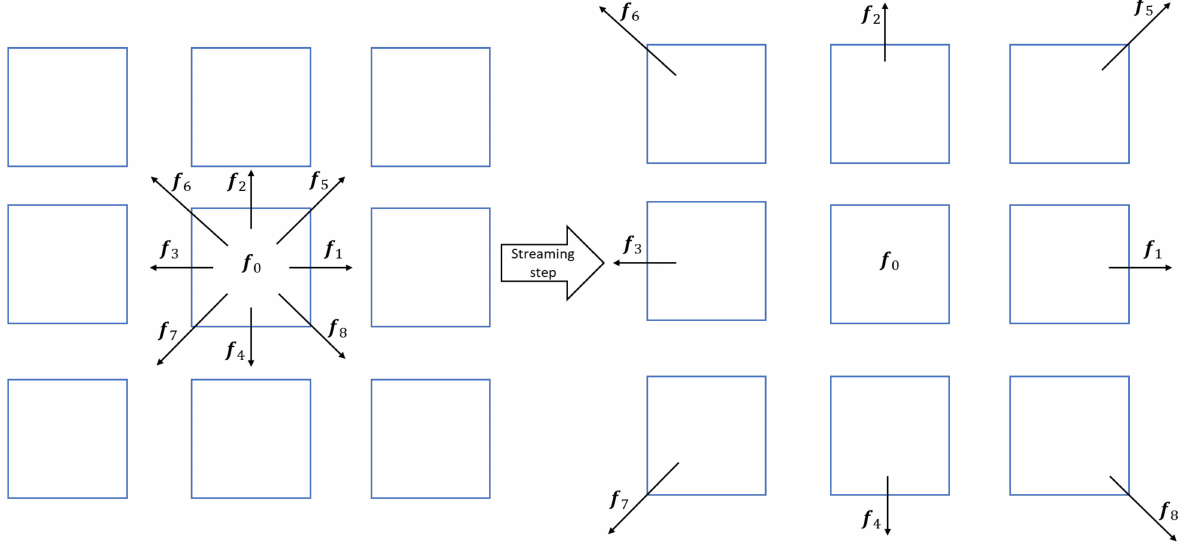
Figure 5. Particles’ motion from cell where f i is the number of particles moving in direction i